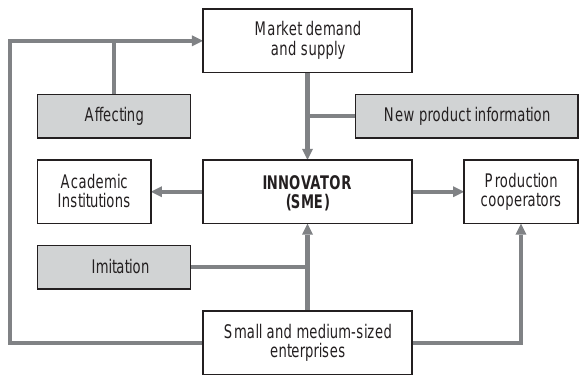
Fig. 1. The Participation of SMEs in the Cluster Innovation